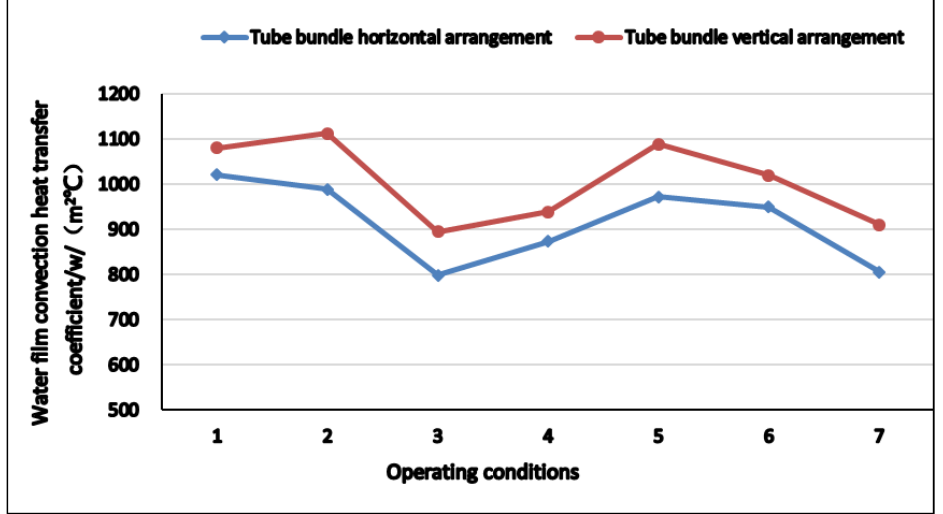
Figure 7. Comparison of the convective heat transfer coefficient of the water film outside the tube bundle under different operating conditions.